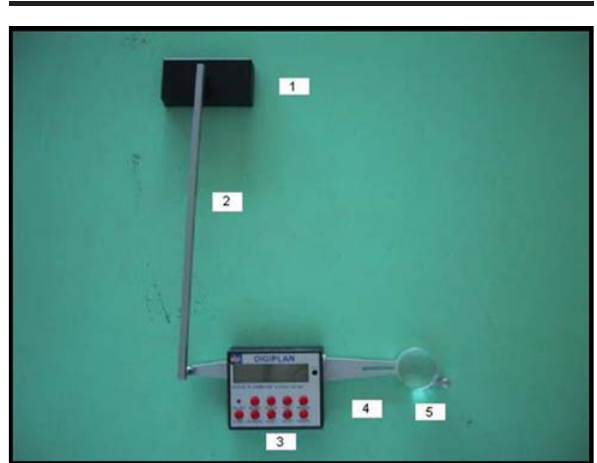
FIGURE 6 - Final aspect of the resected abdominal wall, showing the area of non-stained tissue, corresponding to the adhesion area